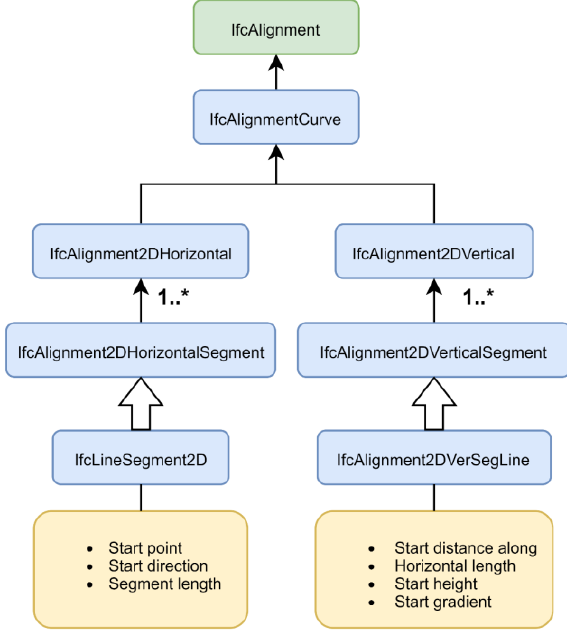
Figure 10. IFC alignment diagram.